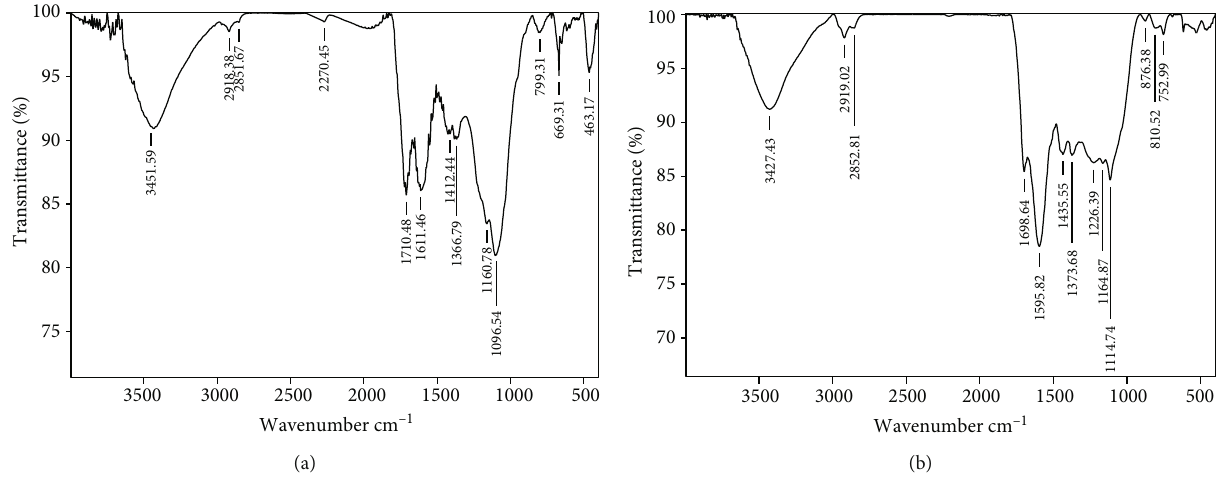
Figure 7: FTIR routine spectrum for (a) ACMAS before adsorption and (b) CV-loaded ACMAS.